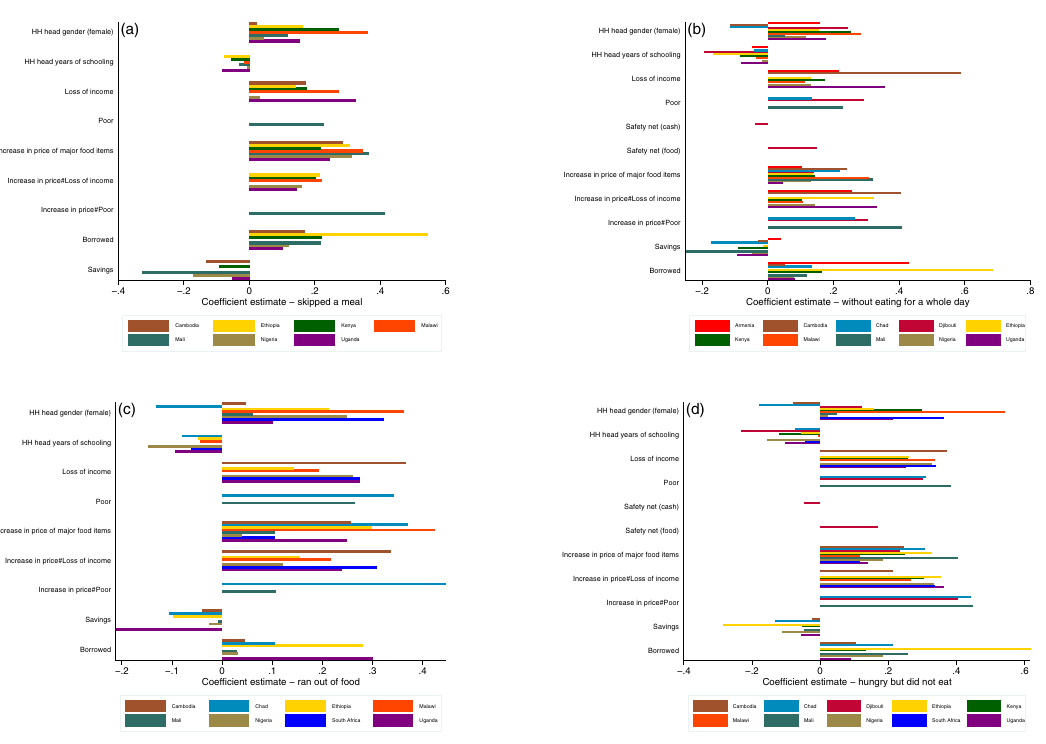
Figure 4. Regression coefficients—showing only statistically significant estimates; ( a ) impact on the probability of skipping a meal, ( b ) impact on the probability of eating for a whole day, ( c ) impact on the probability of running out of food, ( d ) impact on the probability of being